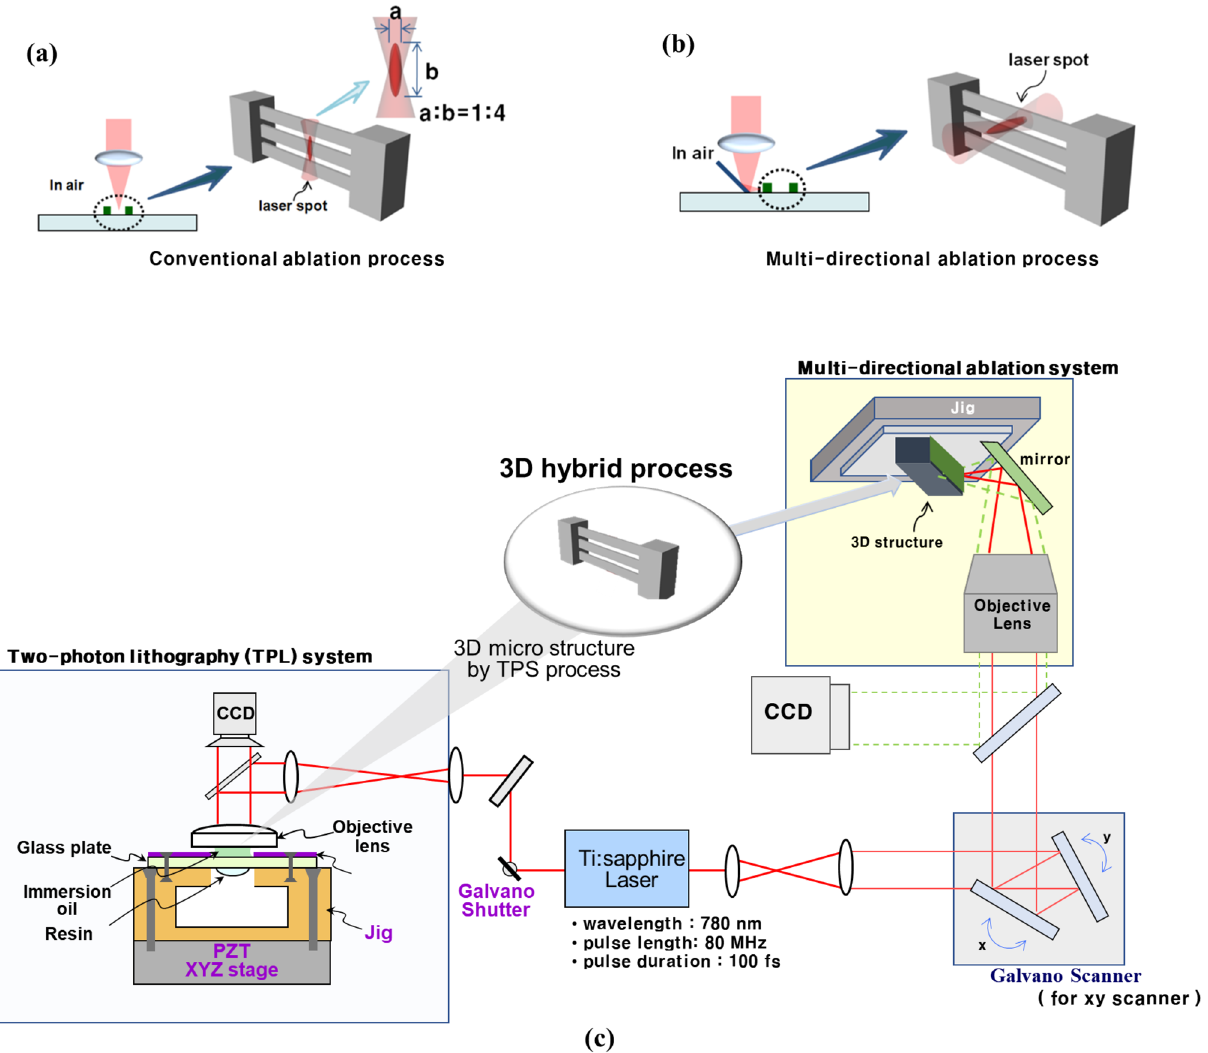
Figure 1. ( a ) Schematic diagram of ( a ) conventional laser ablation process in the vertical direction and ( b ) multi-directional ablation process, which controls the direction of the laser path. ( c ) Diagram showing the 3D hybrid process employing TPS system and multi-directional ablation system. Laser ablation can improve a 3D structure fabricated by the two-photon stereolithography